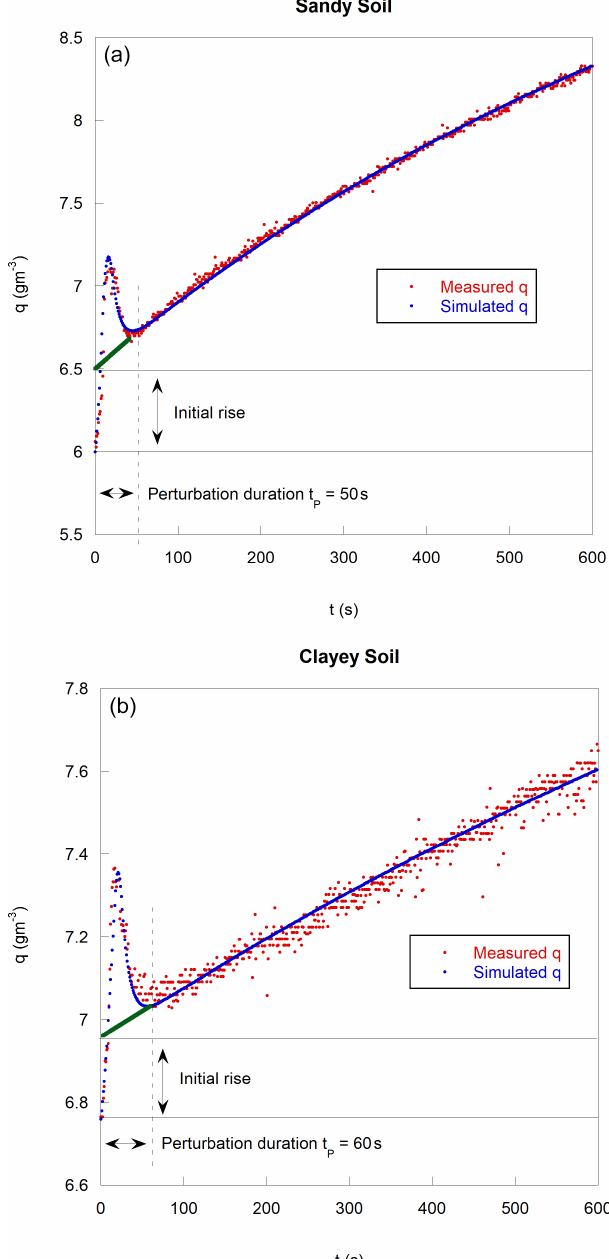
Figure 11. Absolute water vapor concentration versus time. Mea- sured concentration and simulated concentration: (a) sandy soil and (b) clayey